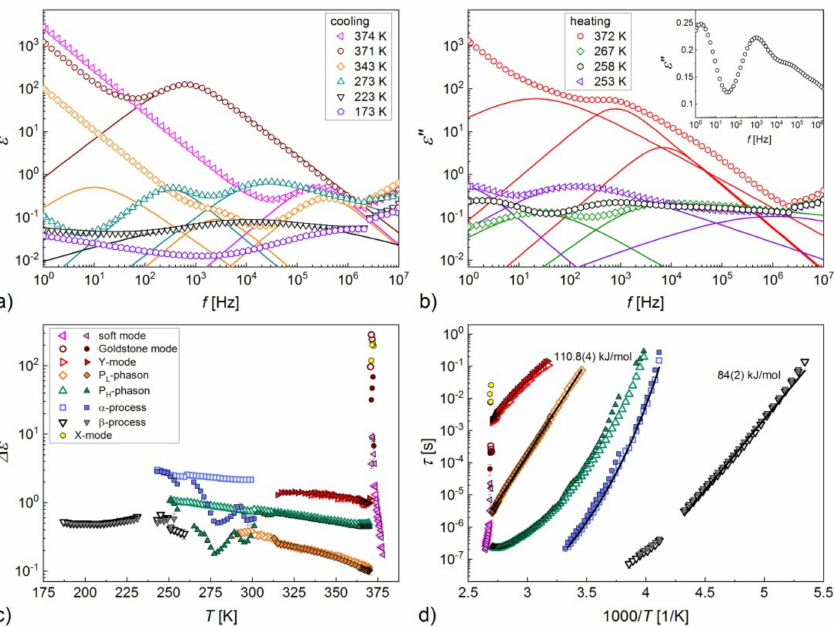
Figure 5. Absorption part of the dielectric spectra of 3F7FPhH6 upon cooling ( a ) and heating ( b ), dielectric strength values vs. temperature ( c ) and Arrhenius plot of relaxation times ( d ). Inset in ( b ) is an enlarged part of the results from 258 K. The lines in ( a , b ) show the fitting results of Equation (1), separately for each relaxation process and with omitted ionic conductivity contribution. The lines in ( d ) show the fitting results of the Arrhenius formula for the P L process and β -process, and fitting results of the Vogel–Fulcher–Tammann equation (Equation (2) for the α -process. Panels ( c , d ) have a common legend; open and solid symbols in these panels correspond to results obtained upon cooling and heating,